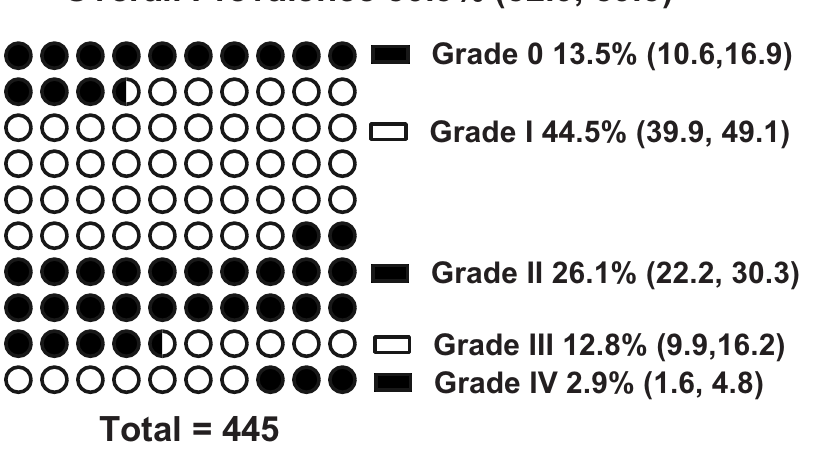
Fig 2. Prevalence estimates. Prevalence estimates (95% CI) by grade of PD.